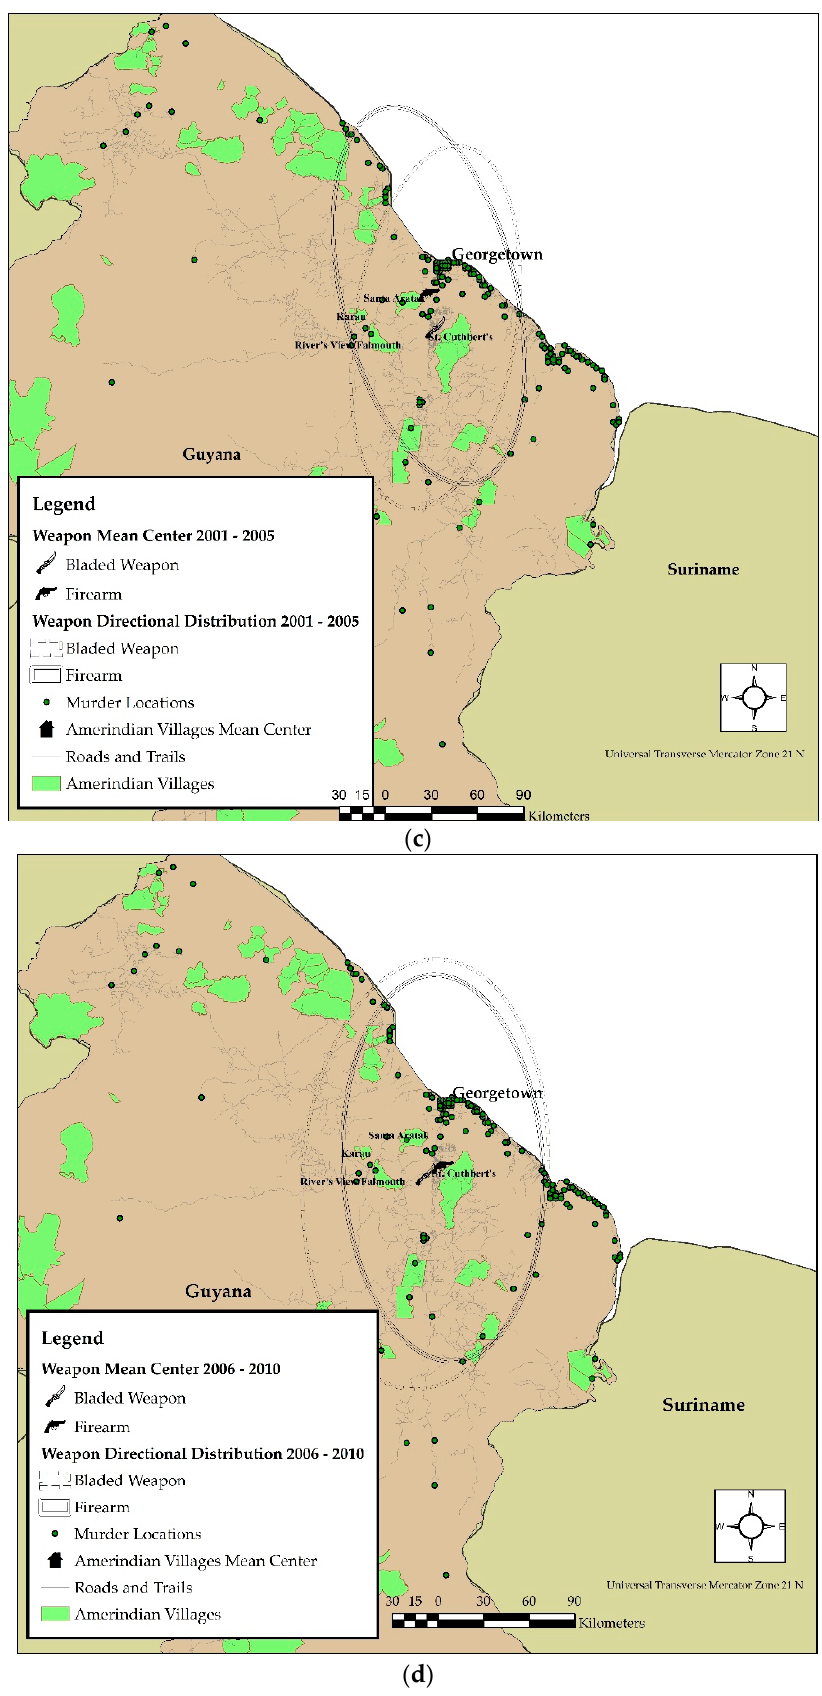
Figure 4. The distribution of murders as inflicted by firearms and bladed weapons; a (top left): 1986–1995; b (top right): 1996–2000; c (bottom left): 2001–2005; and d (bottom right): 2006–2010.